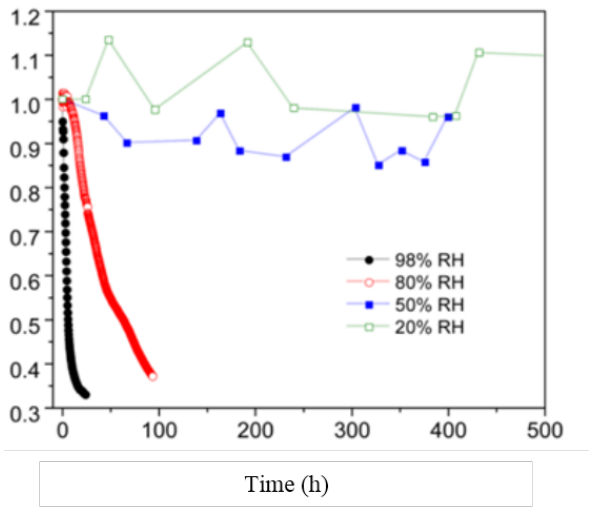
Figure 6: Effect of the moisture on the stability of the perovskite solar cells